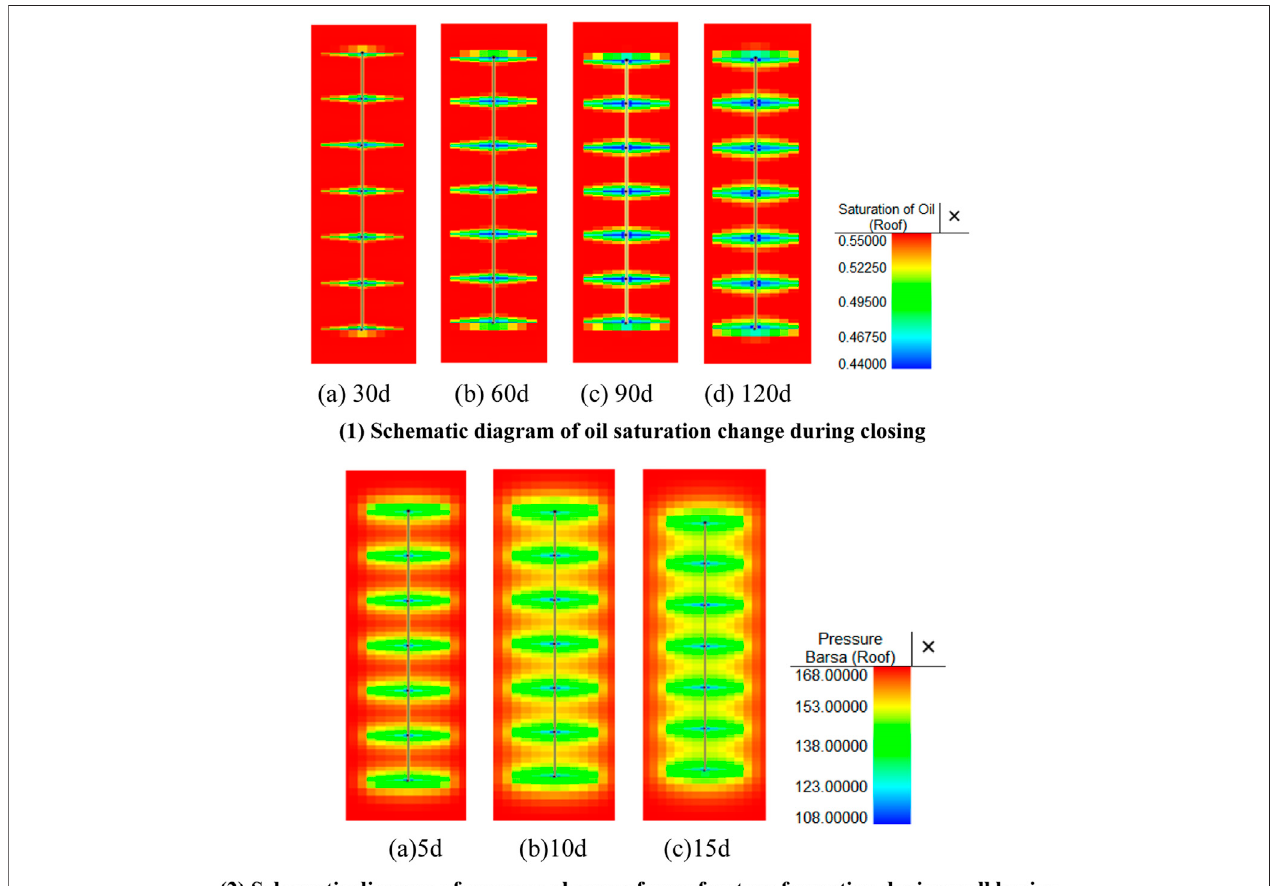
FIGURE 7 | The schematic diagram. (A) Schematic diagram of oil saturation change during closing (i) 30d, (ii) 60d, (iii) 90d, (iv) 120d. (B) Schematic diagram of pressure change of near fracture formation during well boring (i) 5d, (ii) 10d, (iii) 15d.